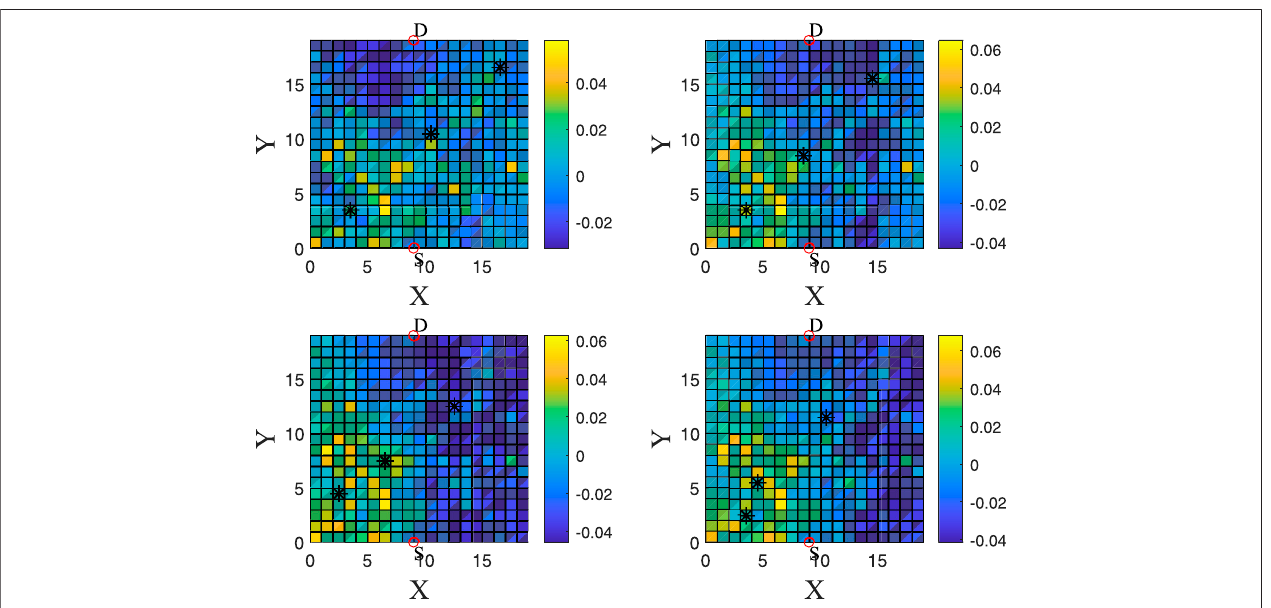
FIGURE3| Thisisaheatmapforvisualizingatrajectoryoftherelays.Wecanseethe V I forallgridcellsforfourdifferenttimesteps(eachtimestephasa2-time-slot differencewiththepreviousandthenext).Onecanseethepositionsoftherelaysforeverytimeslot.Therelaysaremovingtowardsbetterandbetterpositions(larger V I s).